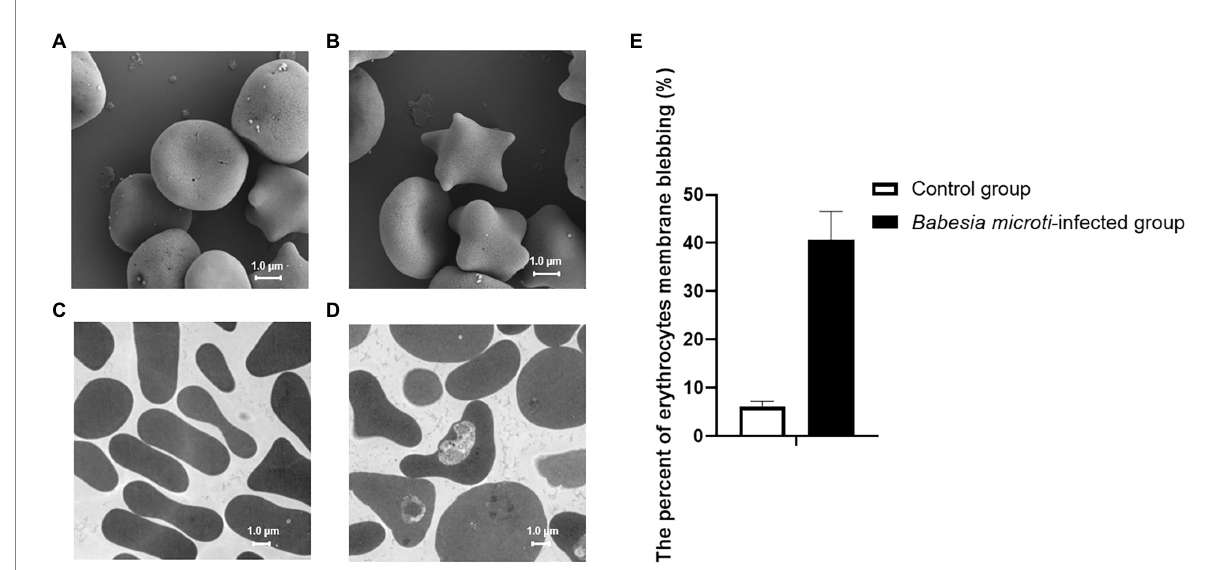
FIGURE 1 Erythrocyte morphology as seen under a scanning electron microscope (SEM) and transmission electron microscope (TEM). (A) SEM image showing biconcave-shaped erythrocytes of mice in the control group. (B) SEM image showing membrane blebbed erythrocytes of mice in the Babesia microti(B. microti) -infected group. (C) TEM image showing regularly shaped erythrocytes of mice in the control group. (D) TEM image showing the changed shape of erythrocytes of mice in the B. microti -infected group. The scale bar is 1.0 μ m. (E) Bar graph showing the arithmetic means ± SD ( n = 5) of the proportion of erythrocytes with a blebbing membrane without (white bar) and with (black bars) B. microti